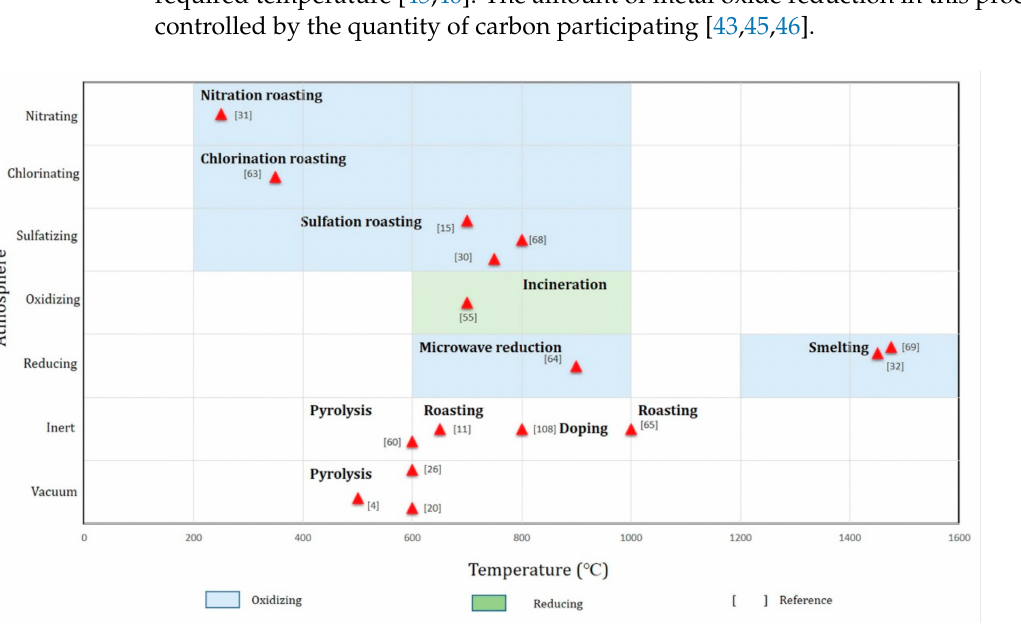
Figure 6. A brief data review of published work on pyrometallurgical options for recycling Li-ion batteries [43]. Reprinted from Journal of Power Sources, Vol. 491, B. Makuza et al., Pyrometallurgical options for recycling spent lithium-ion batteries: A comprehensive review, Copyright (2021), with permission from